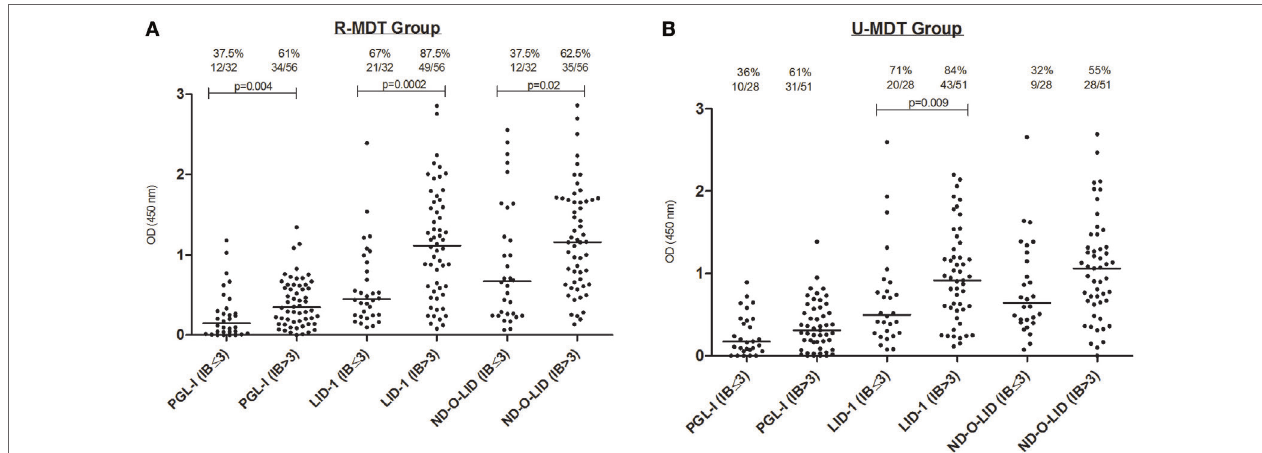
FigUre 3 | Serologic reactivity at 12 months to phenollic glycolipid-I antigen (PGL-I), LID-1, and ND-O-LID antigens among multibacillary (MB) patients stratified by BI ≤ 3 and BI > 3 from the regular multidrug therapy (R-MDT) (a) and uniform multidrug therapy (U-MDT) (B) groups. Each point represents the mean OD of duplicates of each individual patient. The median OD value of each group is represented by the horizontal line and the traced line represents the different cutoffs (PGL-I OD > 0.25, LID-1 OD > 0.3, and ND-O-LID OD > 0.923). The number above each dataset is the percent of positive responses. The p value refers to differences in medians at different time points. OD, optical density; BI, bacilloscopic index.